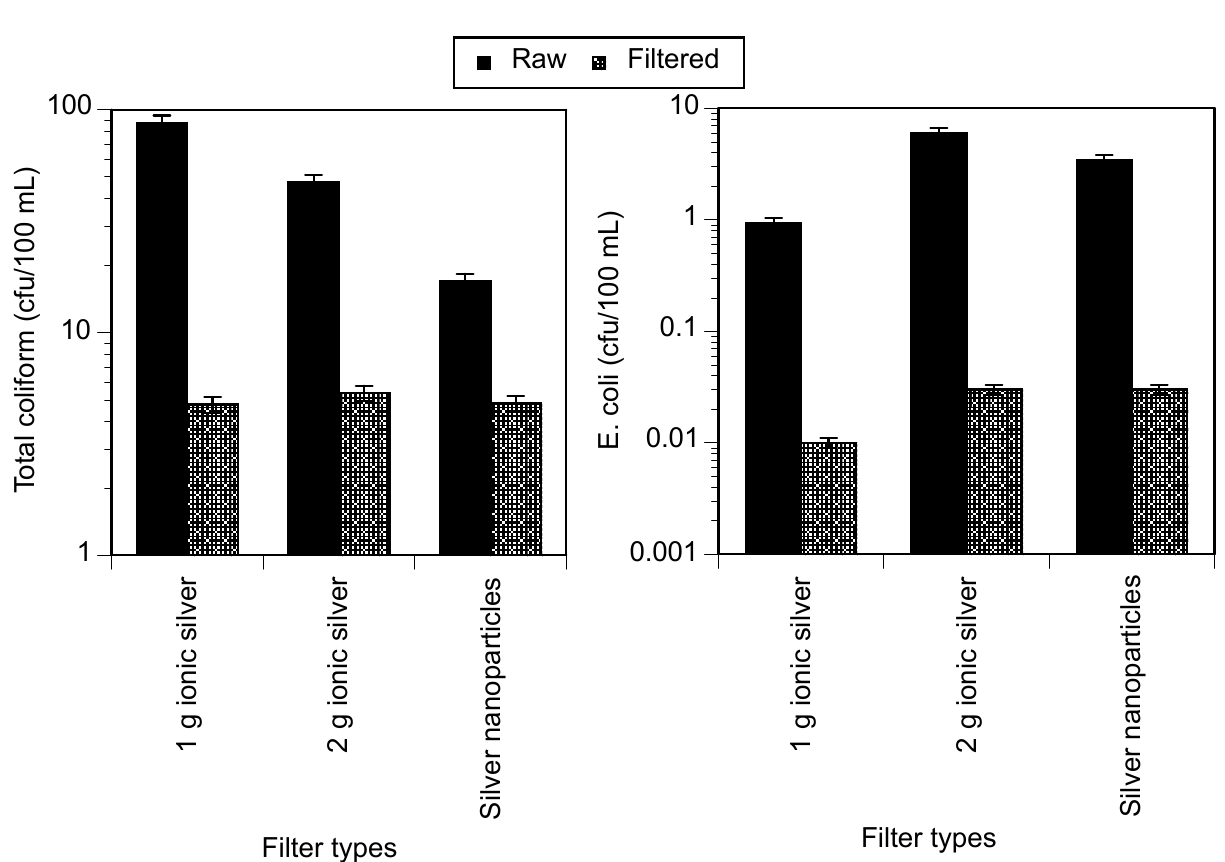
Figure 7. Total coliform ( left ) and E. coli ( right ) inactivation using the various filter types (n = 1040). A calculation of the percentage total coliform and E. coli removal by 1 g, 2 g and silver nanoparticles filters over 13 months period was carried out, and results show that the different filters result in similar levels of total coliform and E. coli removal (Table 3). It found that silver nanoparticles filters had a slightly lower removal efficiency of total coli- form (72%) compared to 1 g and 2 g silver nitrate filters. Table 3. Percentage coliform removal for total coliform and E. coli by 3 filter types.